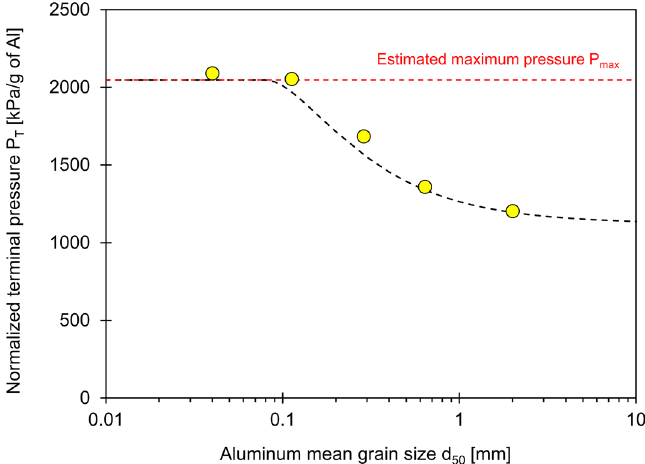
Figure 5. Terminal pressure P T per gram of aluminum versus aluminum chip size d 50 . The red dotted line denotes the estimated maximum pressure P max = 2047 kPa calculated by assuming a complete reaction (Eq. 5). The black dotted line considers the reacted mass as a function of aluminum chip size d (Eq. 6). Values used for the fitting model involve the chip thickness a = 0.15 mm and skin thickness h = 40